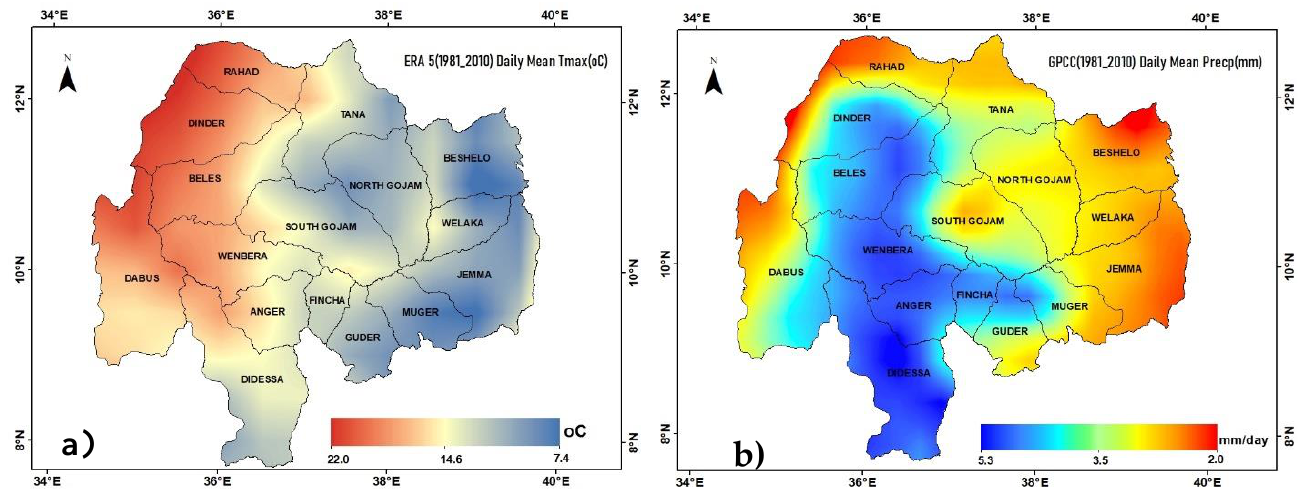
Figure 3. Spatial distribution of ( a ) ECMWF-ERA5 mean annual max. temperature (°C) and ( b ) GPCC precipitation